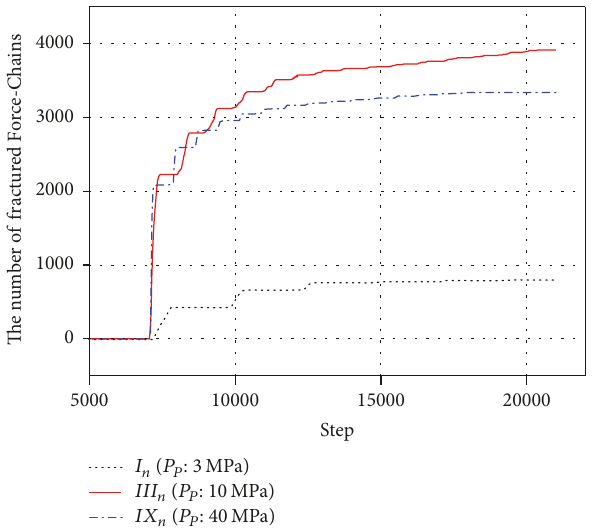
Figure 12: Growth curves of fractured Force-Chains under repeated-impacts of HWSWs.